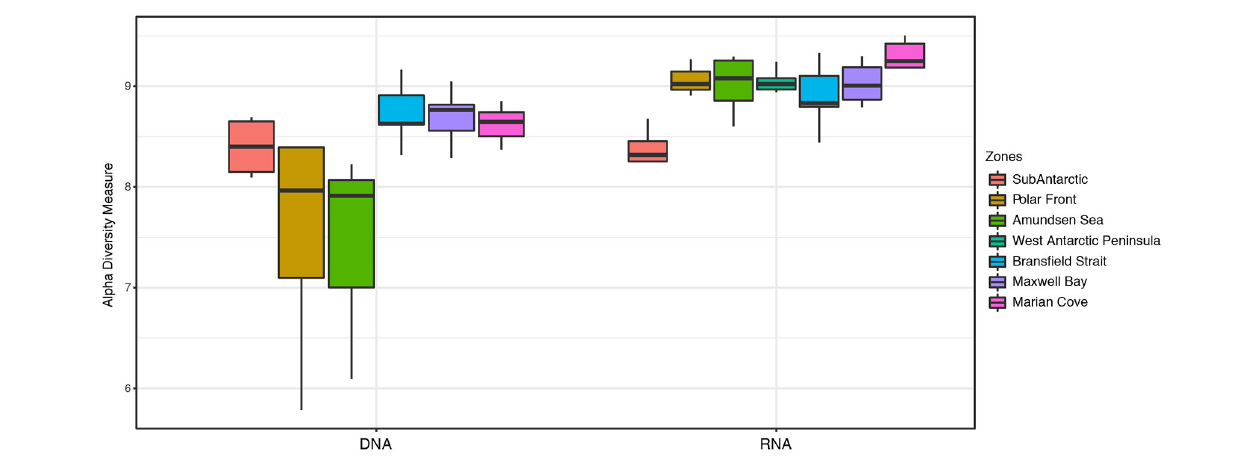
FIGURE 4 | Shannon α -diversity index across seven zones, comparing 16S rRNA gene and 16S rRNA-based fractions of the microbial community from surface samples (0, 7, and 10m).